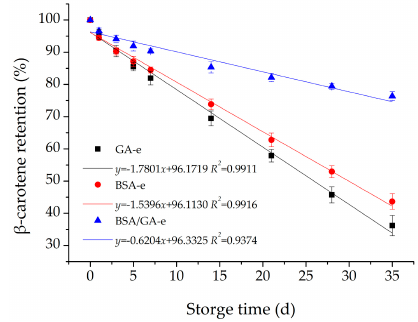
Figure 6. The effects of storage time (25 °C) on the β -carotene retention of the three emulsions studied. The β -carotene retention of the three emulsions studied were measured after storage without light for 0, 1, 3, 5, 7, 14, 21, 28, 35 d. Each data point is an average of triplicate, and the standard deviations are given. Solid lines represent the fitting results from the linear equation using OriginPro.